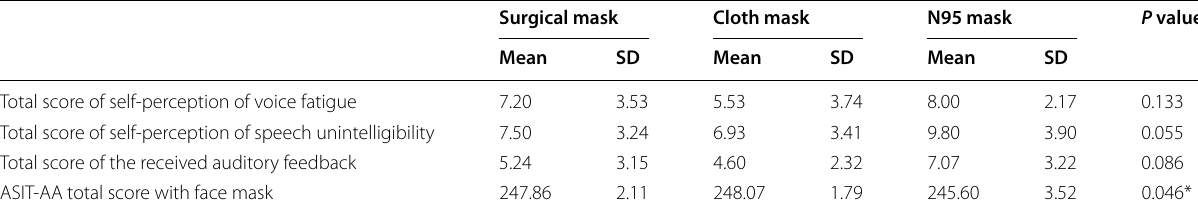
Table 10 Comparison between face mask types regarding the total scores of self‑perception of voice fatigue, self‑perception of speech unintelligibility, and the received auditory feedback